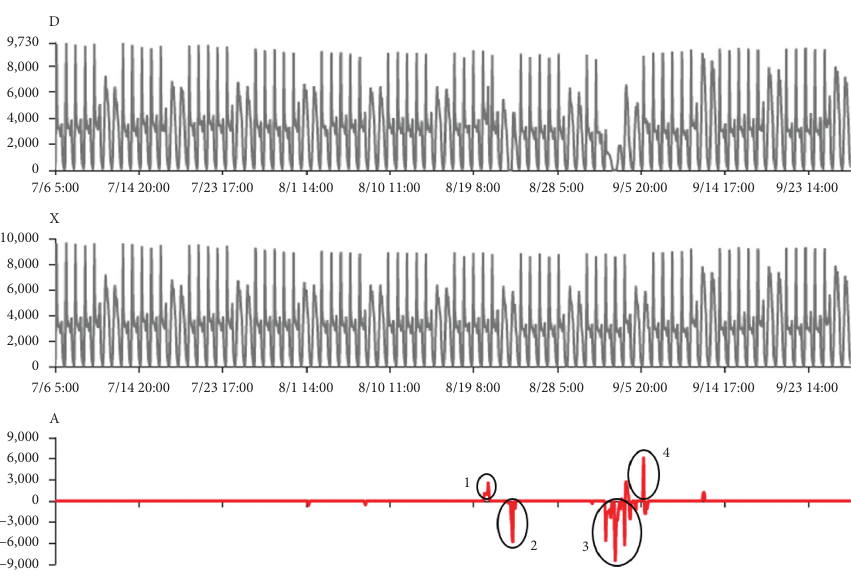
Figure 5: Component decomposition of exit flow of Xidan station by the improved RPCA. The horizontal axis is time interval covering 12 weeks, and the vertical axis is traffic